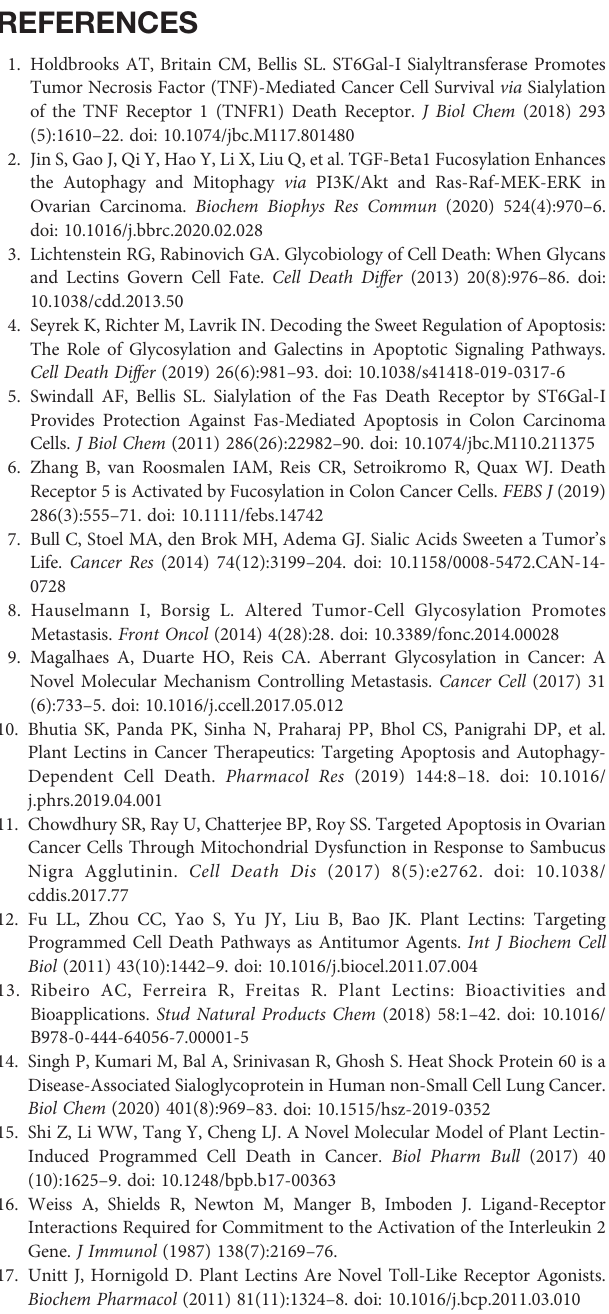
Supplementary Figure 2 | ValidationofGNEgeneknockoutinMC-38by fl ow cytometryusingConA,MALII,andECL.GNEknockoutwasperformedusingsgRNAs targetingeitherexon5(clone1) (A) ,orexon9(clone2) (B) .Eachlectinwasusedat10 m g/ml. Supplementary Figure 3 | Veri fi cation of caspase 9 cleavage in MC-38 treated with lectins. (A) Immunoblot of caspase 9 in MC-38 treated with lectins and the